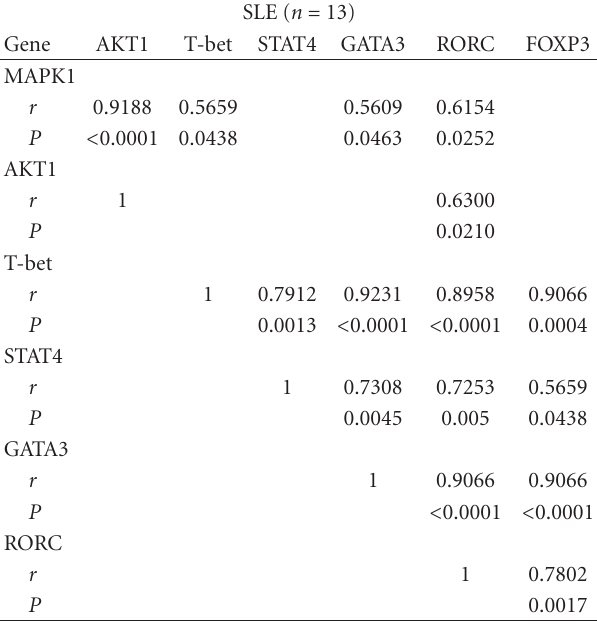
Table 7: Spearman’s rank correlations found between gene expressions of AKT1, MAPK1, FOXP3, cytokines, IL-10, and Th- transcription